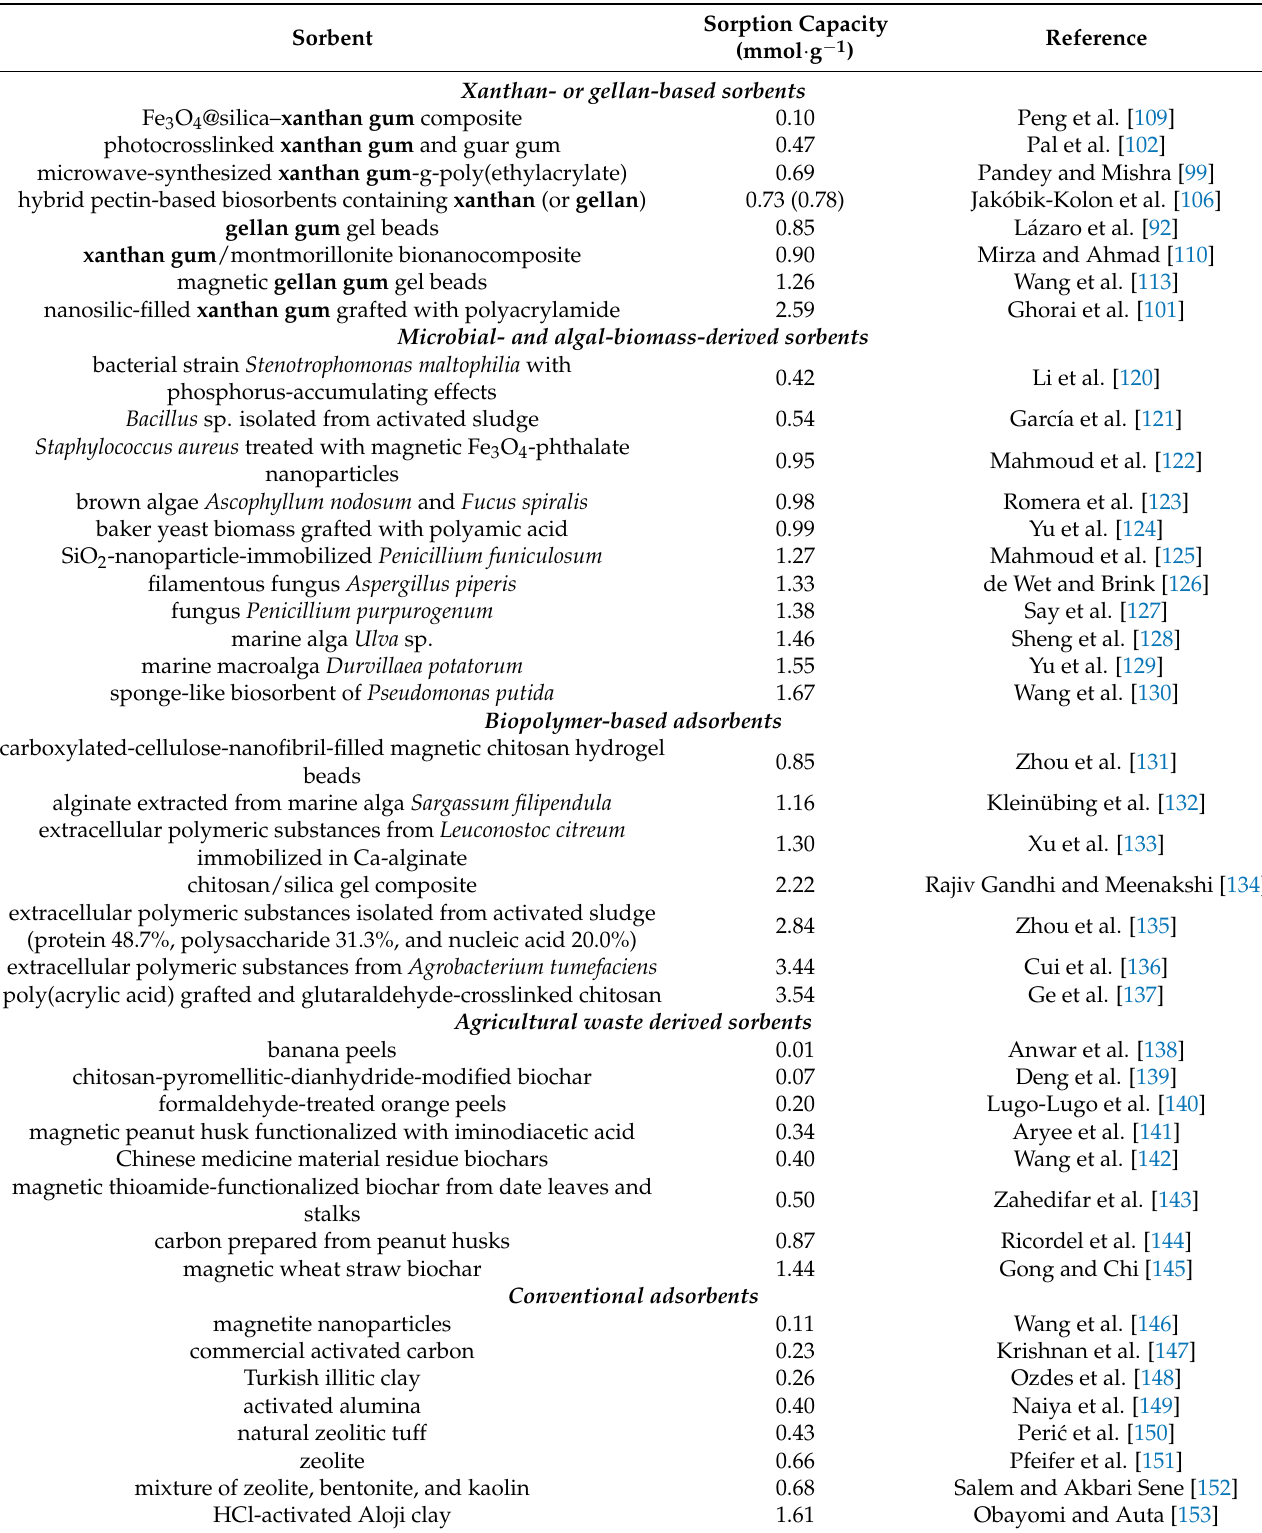
Table 1. Reported maximum sorption capacities of xanthan- and gellan-based sorbents along with other conventional and non-conventional sorbents for lead(II) (the values indicate the maximum sorption capacities calculated from Langmuir